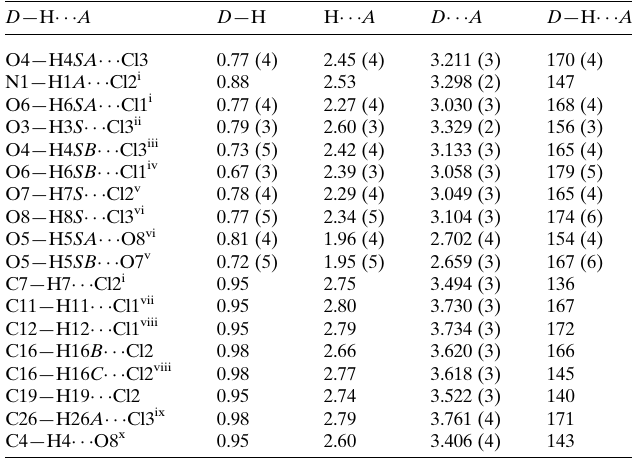
Table 3 Hydrogen-bond geometry (A˚ , (cid:3) ) for the Dy III